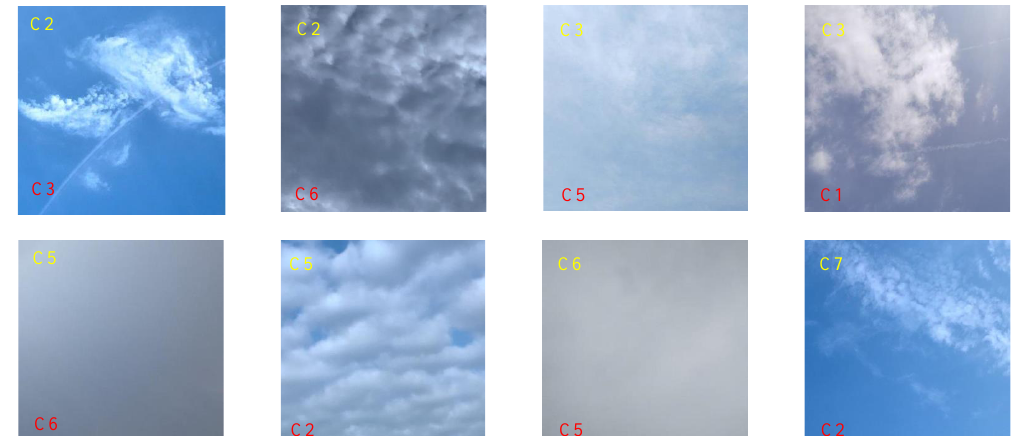
Figure 6. Confusion matrix of the proposed CSSL method.